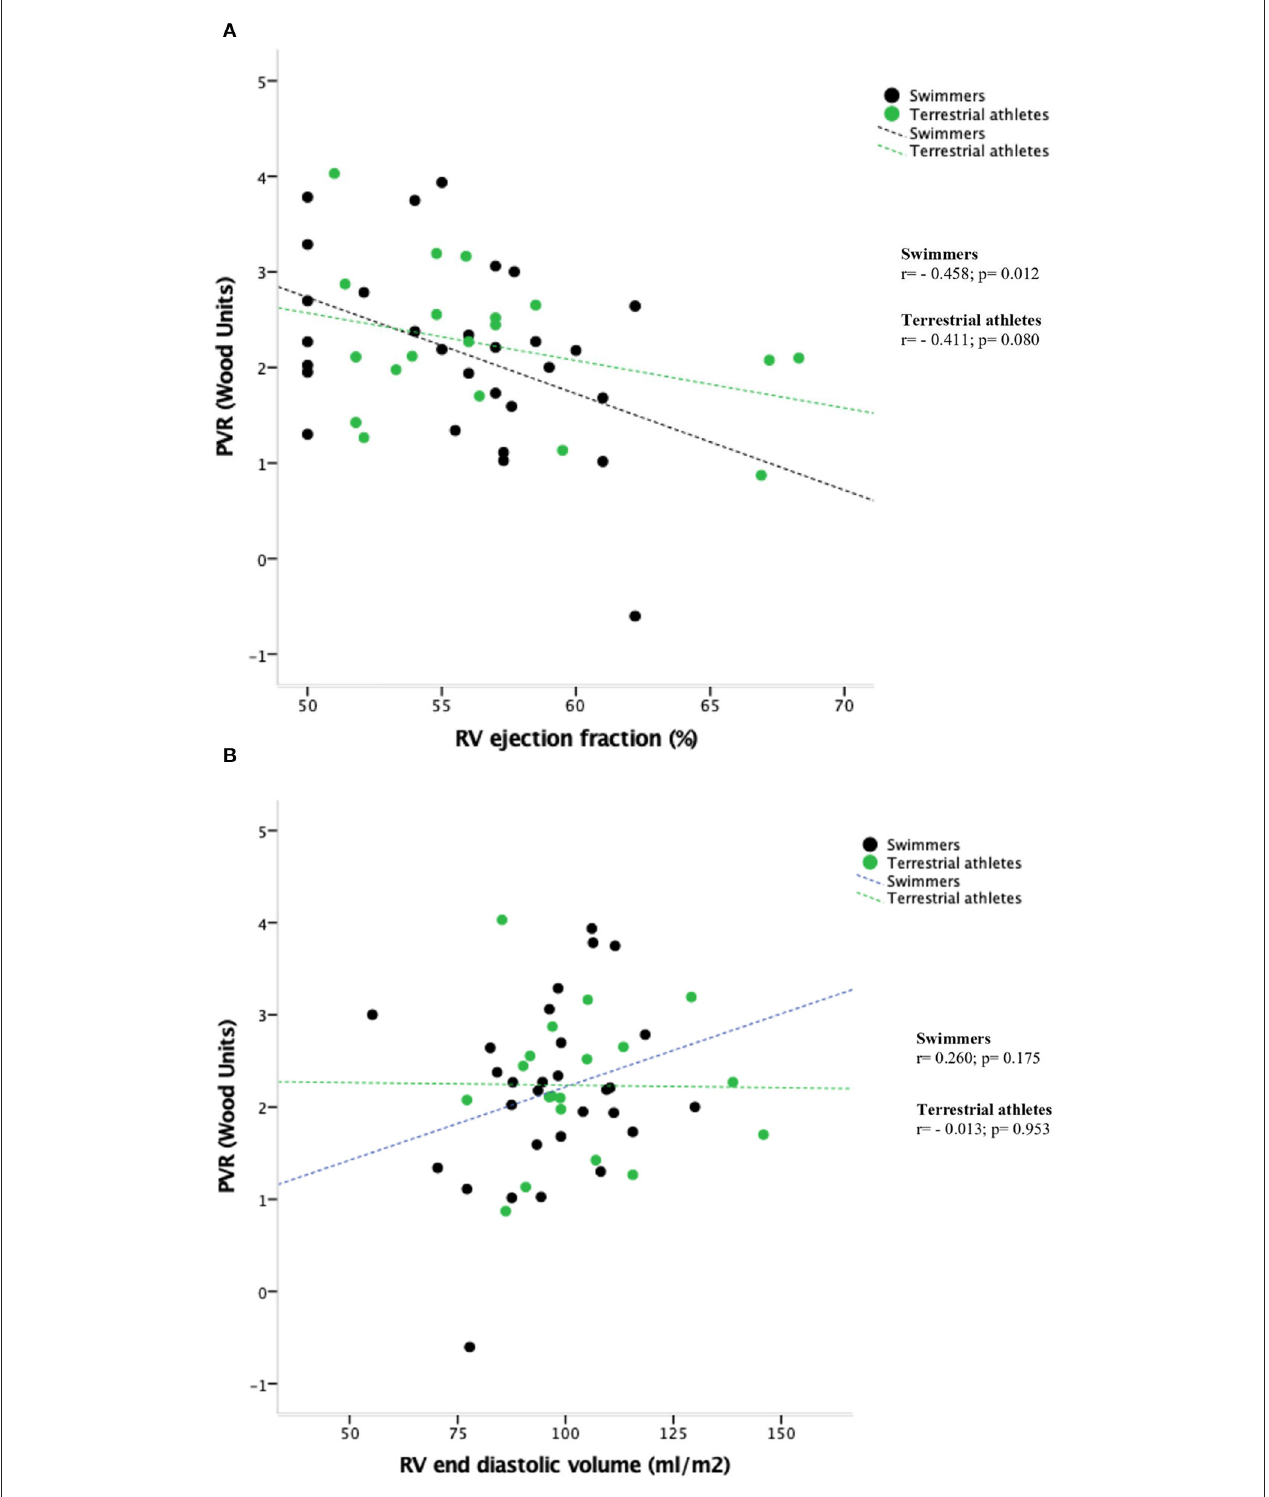
FIGURE 2 | (A) Relationship between RV ejection fraction and cardiac-magnetic resonance-estimated pulmonary resistance (PVR) values. (B) Relationship between RV end diastolic volume and cardiac-magnetic resonance-estimated pulmonary resistance (PVR) values.